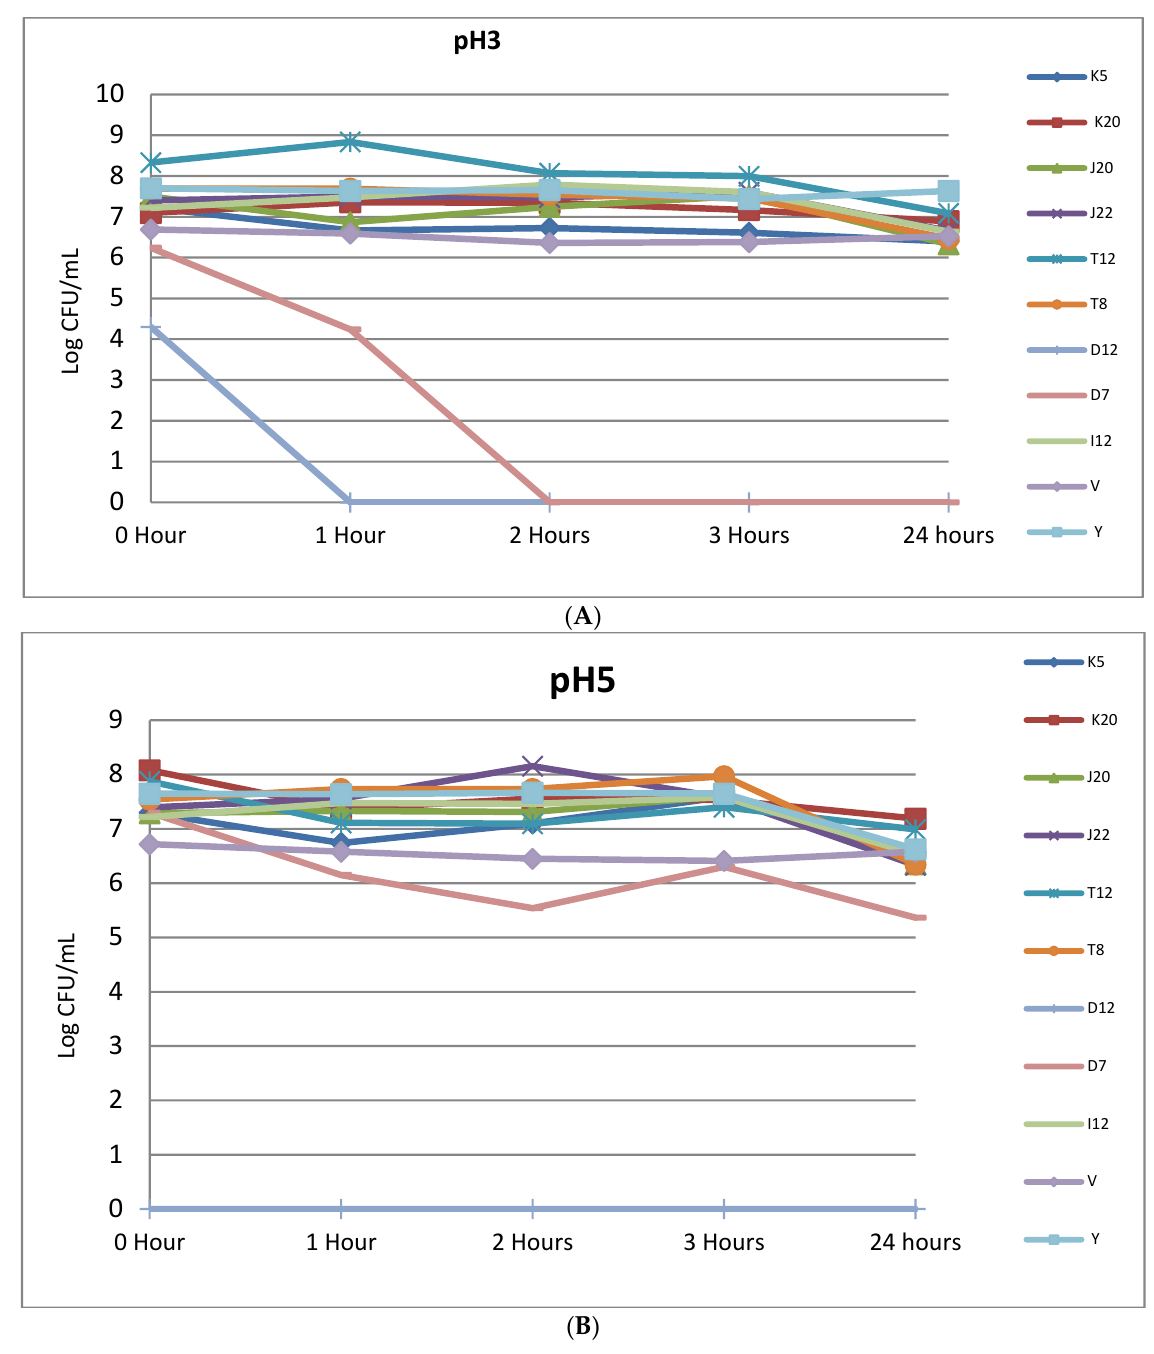
Figure 3. ( A ) Viability of LAB strains incubated in phosphate buffered saline at pH 3 for 24 h at 37 °C; ( B ) The viability of Lactobacillus strains subjected to acid-stress conditions at pH 5 for 24 h at 37 °C. Isolate codes (K5, K20, J20, J22, T12, T8, D12, D7 and I12) represented by single letter and number indicate the strain number where they were isolated.